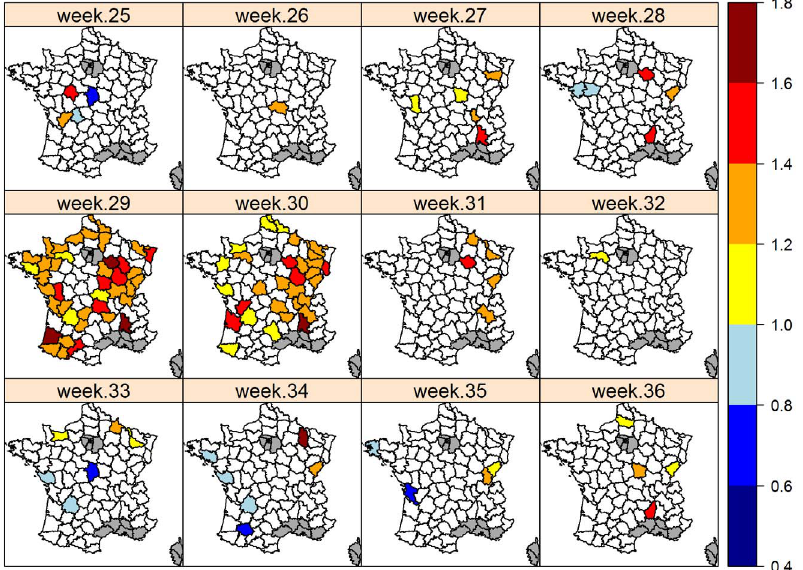
Figure 5. Geographic distribution of the weekly mortality ratio (O/E) in 2006. French departments in white correspond to departments where Observed/Expected mortality is not significantly different from 1. Mortality was not modeled in departments in gray due to the scarcity of cattle populations.